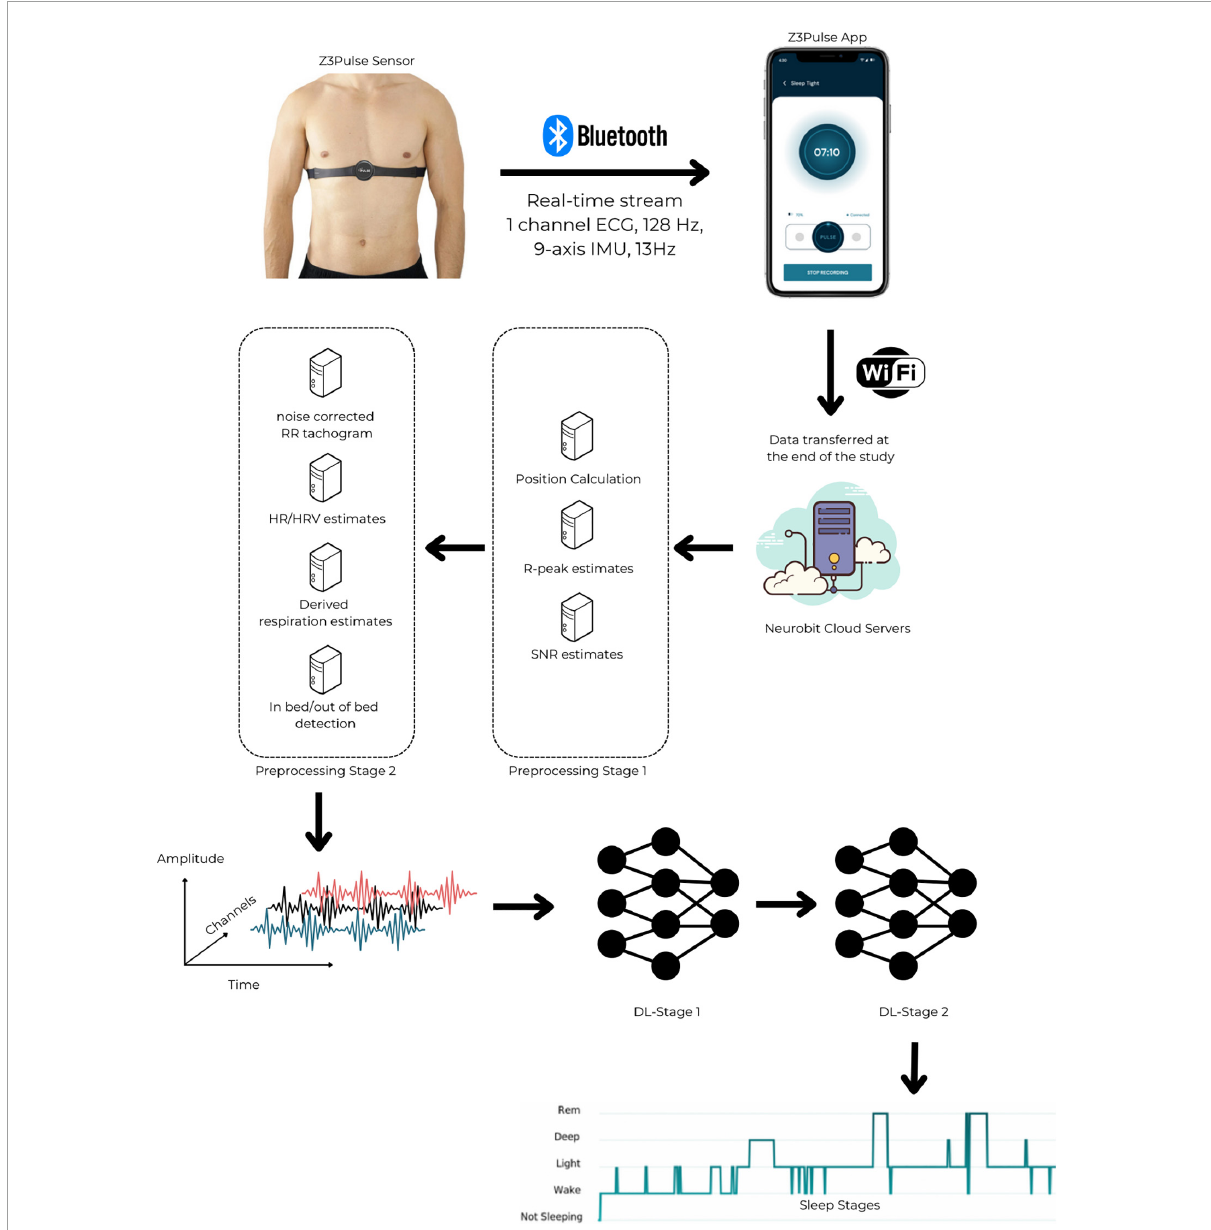
FIGURE2 The Z3Pulse system and processing pipeline – from data acquisition to automated sleep stage scoring. The Z3Pulse sensor is a chest-worn wearable. It is secured by a one-time Ag-Cl patch or by a reusable belt. It transmits a single channel ECG and inertial measurement unit data in real-time to the Z3Pulse App. The app is operated via a user-friendly interface and stores the data locally for the entire duration of a recording. Once a given overnight sleep study is terminated, the collected data is transmitted to the Neurobit Cloud Servers. The data undergoes two stages of pre-processing. In the Preprocessing Stage 1, the analytics mounted on the Neurobit Cloud Servers enable the calculation of sleep position and detection of R-peaks (alongside the associated SNR values). Subsequently, these derivatives are pushed forward into the pipeline (to the Preprocessing Stage 2). At this stage, the noise-corrected RR tachogram, HR, HRV, the derived respiration estimates are calculated. Additionally, leveraging the position data (derived at the Preprocessing Stage 1), the in bed/out of bed score if obtained for each available/accepted epoch. The time-series data originated at the Preprocessing Stage 2 is then fed to two-stage deep-learning models. In a nutshell, the deep-learning model is based on a temporal convolutional model (Lea et al., 2017) with inception-residual networks (Szegedy et al., 2017). The first stage (DL-Stage 1) has 492,420 parameters and the second stage (DL-Stage 2 has 538,796 parameters. These networks use temporal convolutional networks along with inception layers. Overall, the two stages combined have a total of 1,031,216 parameters. Benefiting from the users’ feedback, an updated version of the pipeline mounts the Preprocessing Stage 1 is directly onto the device. Such processed data is stored locally in device memory. These results are transmitted via Bluetooth to the Z3Pulse App when a given recording is terminated. This updated architecture virtually prevent any data loss due to disconnections of the Z3Pulse Sensor from the Z3Pulse App during an overnight sleep